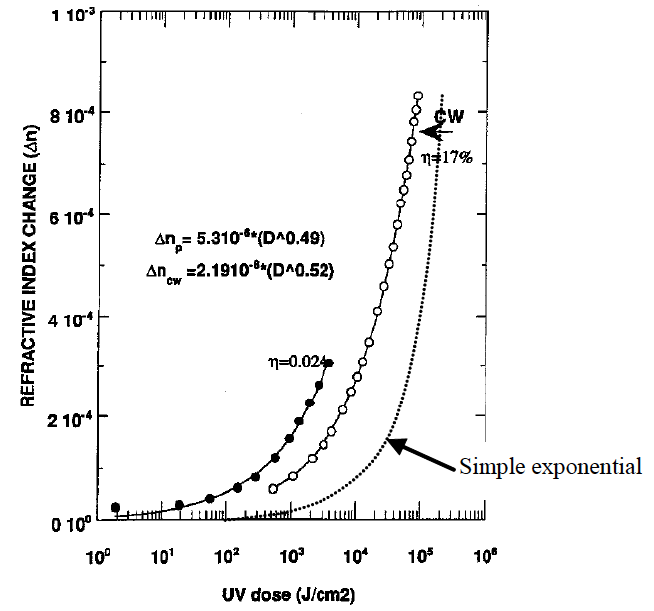
Figure 1. Index change under UV irradiation, reprinted with permission from [7]. Copyright 1996 Elsevier.